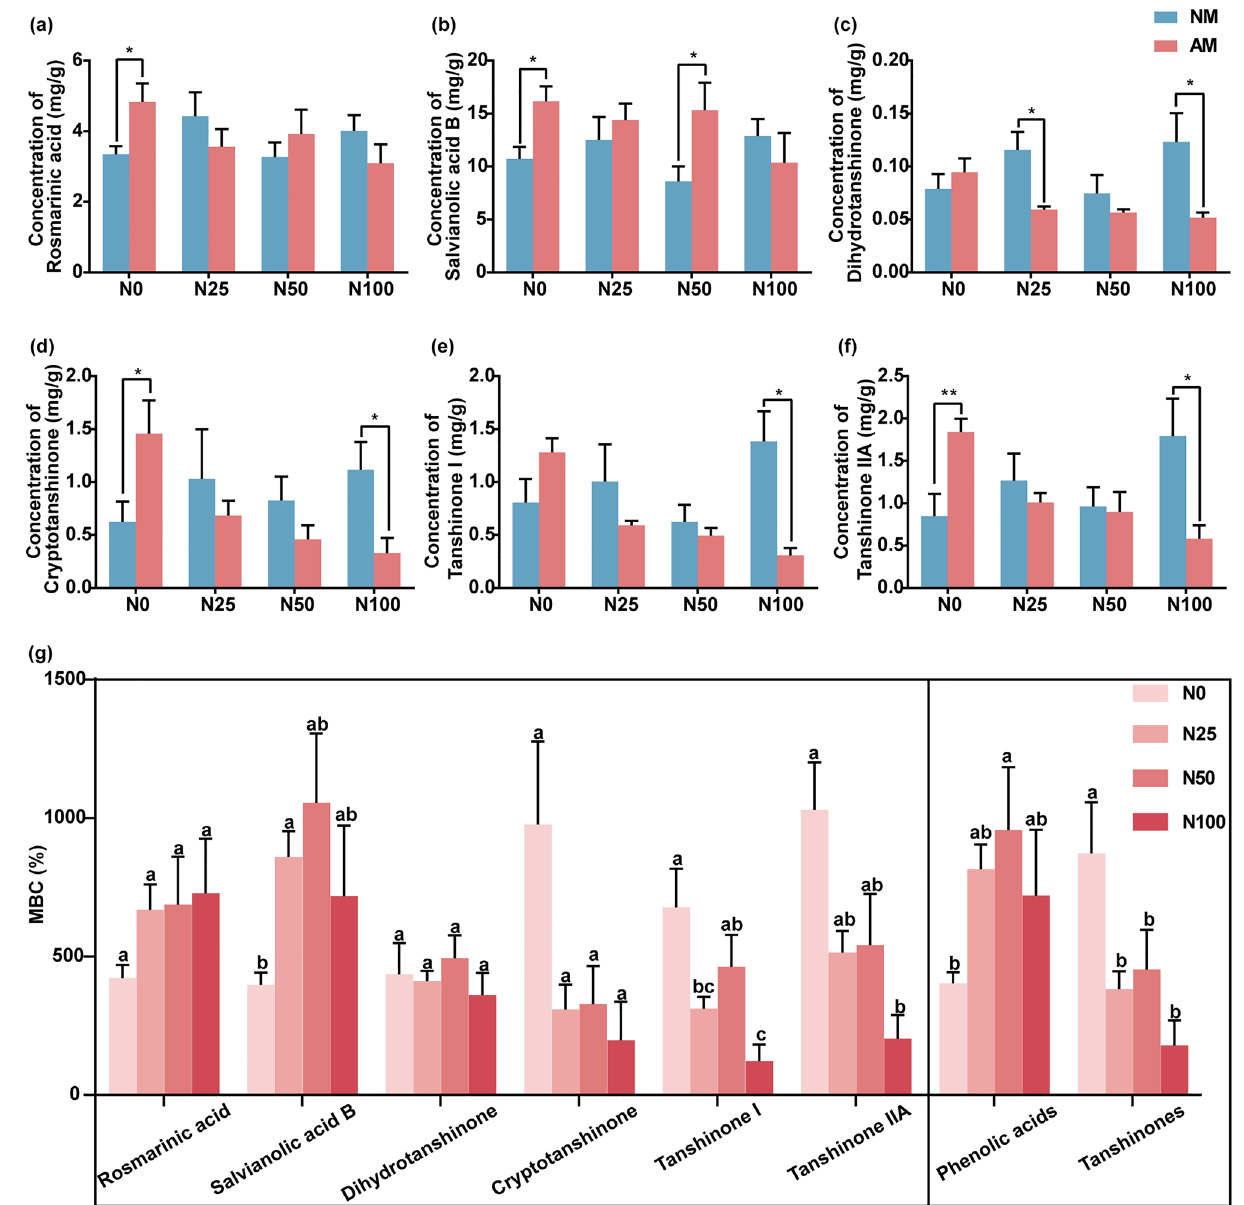
Figure 4. Mycorrhizal response of bioactive compounds (MBC) under different levels of N (0, 25, 50, and 100 mg N fertilizer added per kilogram of soil; N0, N25, N50, N100) fertilizer. ( a–f ) The concentrations of bioactive compounds, rosmarinic acid ( a ), salvianolic acid ( b ), dihydrotanshinone ( c ), cryptotanshinone ( d ), tanshinone I ( e ), tanshinone IIA ( f ) in the roots of S. miltiorrhiza under different treaments. The means ± standard errors are shown (n = 6). Asterisks indicate significant differences between arbuscular mycorrhizal plants and non-mycorrhizal plants according to the t-test (*0.01 ≤ P ≤ 0.05, **0.001 ≤ P ≤ 0.01, *** P ≤ 0.001). ( g ) Mycorrhizal response of bioactive compounds (MBC) under different levels of N. The means ± standard errors are shown (n = 6). Different lowercase letters indicate significant differences between different treatments according to one-way ANOVA followed by Tukey’s test for multiple comparisons ( P < N fertilizer application increased the RLC, MGR, and the accumulation of phenolic acids. Nouri et al. 39 showed the inhibition of P is influenced by other nutritional pathways in the interaction between Petunia hybrida and Rhizophagus irregularis , and N and P are the major nutritional determinants of the interaction. Interestingly, the symbiosis-promoting effect of nitrogen starvation dominantly overruled the suppressive effect of high phos- phorus nutrition onto arbuscular mycorrhiza, suggesting that plants promote the symbiosis as long as they are limited by one of the two major nutrients. Hence, how does N and P fertilizer interactions co-regulate mycor- rhizal symbiosis worth further study.